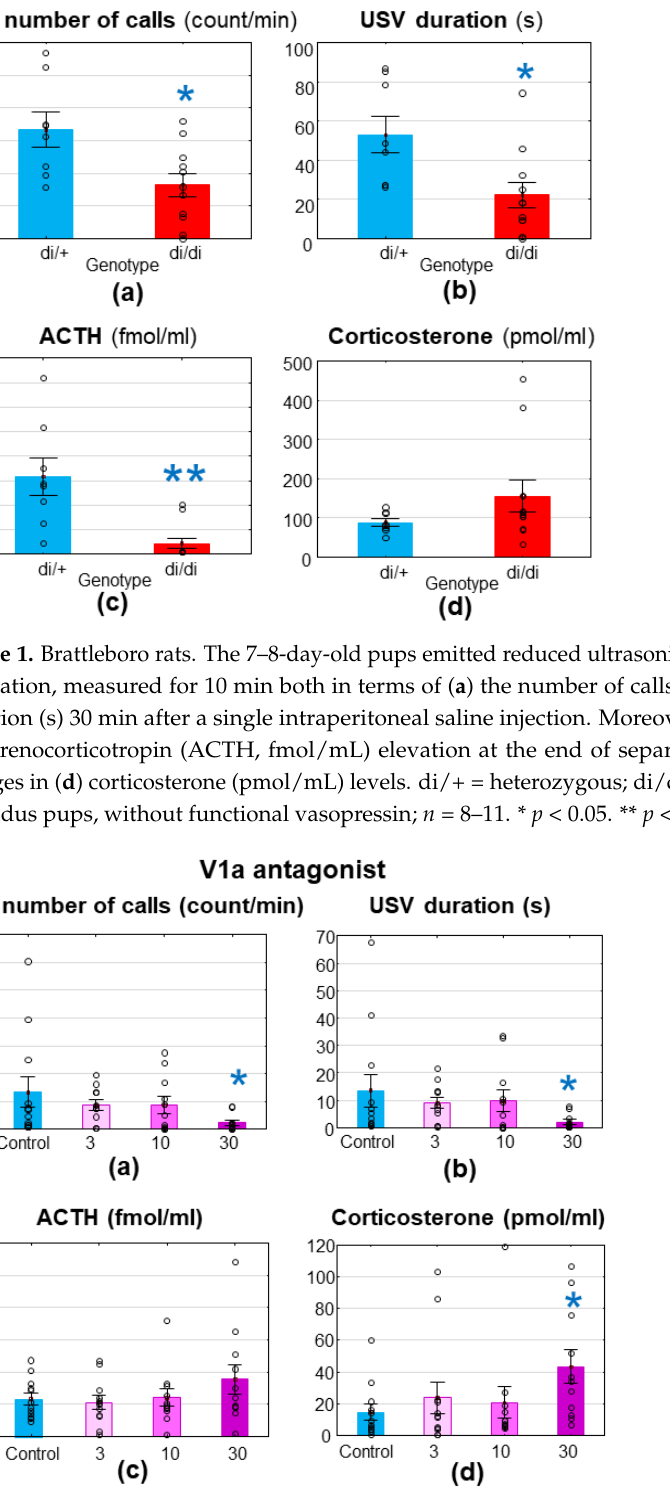
Figure 2. Wistar rats, treated with SR49059, a vasopressin (V) 1aR antagonist. The 7–8-day-old Wistar rat pups were treated intraperitoneally with a 3, 10 or 30 mg/kg V1aR antagonist 30 min before a 10 min maternal separation. The 30 mg/kg dose significantly reduced the emitted ultrasonic vocalization both in terms of ( a ) the number of calls and ( b ) the duration without changes in ( c ) adrenocorticotropin (ACTH, fmol/mL), but an elevation in ( d ) corticosterone (pmol/mL) levels. n = 12–14. * p < 0.05 vs. control. There was no difference between the groups in the latency of the righting reflex as well as the negative geotaxis (Table 1). Table 1. Righting reflex and negative geotaxis values.